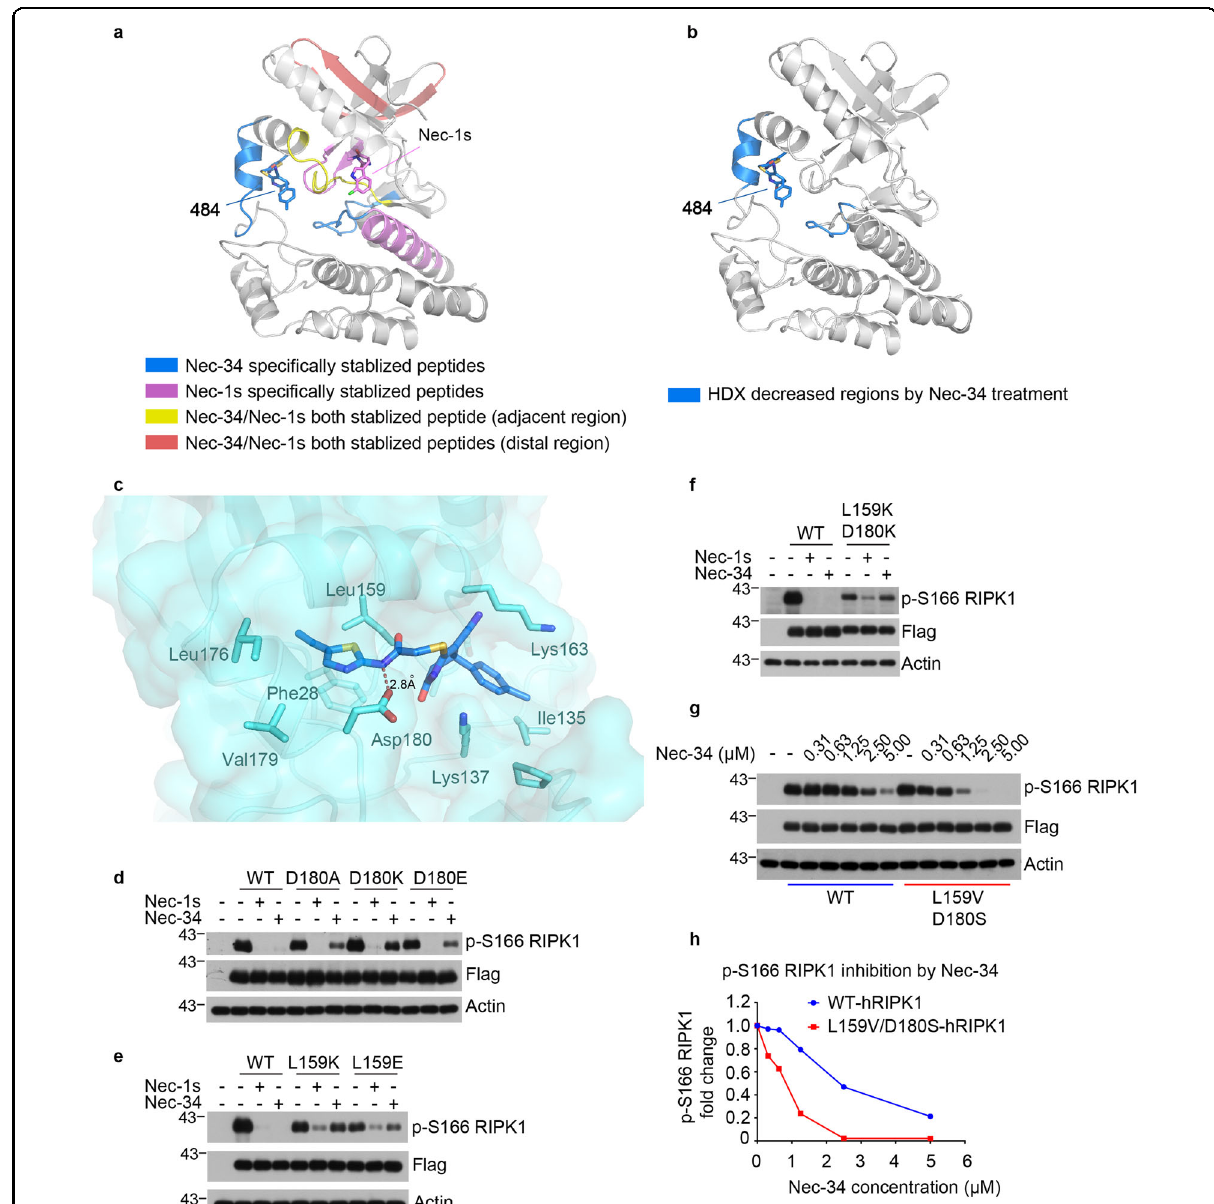
Fig. 5 Validation of Nec-34-binding sites in RIPK1 kinase. a LiP-MS analysis of Nec-34-binding sites. Nec-34- and Nec-1s-stabilized peptides were mapped to aligned structure of 484 and Nec-1s with RIPK1 in Fig. 4e. 484-bound RIPK1 was colored gray. Peptides speci fi cally stabilized by Nec-34 were colored blue. Peptides speci fi cally stabilized by Nec-1s were colored magenta. The peptide stabilized by both Nec-34 and Nec-1s in the adjacent region was colored yellow. Peptides stabilized by both Nec-34 and Nec-1s in the distal region were colored red. b HDX-MS analysis of Nec- 34-binding sites. Regions with decreased hydrogen deuterium exchange were mapped to the predicted binding model of 484 in Fig. 4d. HDX- decreased regions were colored blue. c A closed-up view of the 484-binding sites of RIPK1 according to the predicted binding mode of 484 in Fig. 4d. 484 was shown in blue sticks, the binding sites of 484 was shown in cyan sticks. The H-bond was shown in red dashed line. d – f 293T cells were transfected with Flag-tagged WT-RIPK1 (residues 1 – 330), Asp180 mutants of RIPK1 ( d ), Leu159 mutants of RIPK1 ( e ), or L159K/D180K double-mutant of RIPK1 ( f ) for 20 h. Cells were treated with 10 μ M Nec-1s or Nec-34 12 h after transfection. Cells were lysed with Nonidet P-40 buffer and the cell lysates were analyzed by western blotting with indicated antibodies. g 293T cells were transfected with Flag-tagged WT-hRIPK1 (residues 1 – 330) or L159V/D180S double-mutant of hRIPK1 for 20 h, and treated with different concentrations of Nec-34 12 h after transfection. Cells were lysed with Nonidet P-40 buffer, and then cell lysates were analyzed by western blotting with indicated antibodies. h The signal intensities of bands from g were analyzed by ImageJ and showed by fold-change of p-S166 RIPK1 in different concentrations of